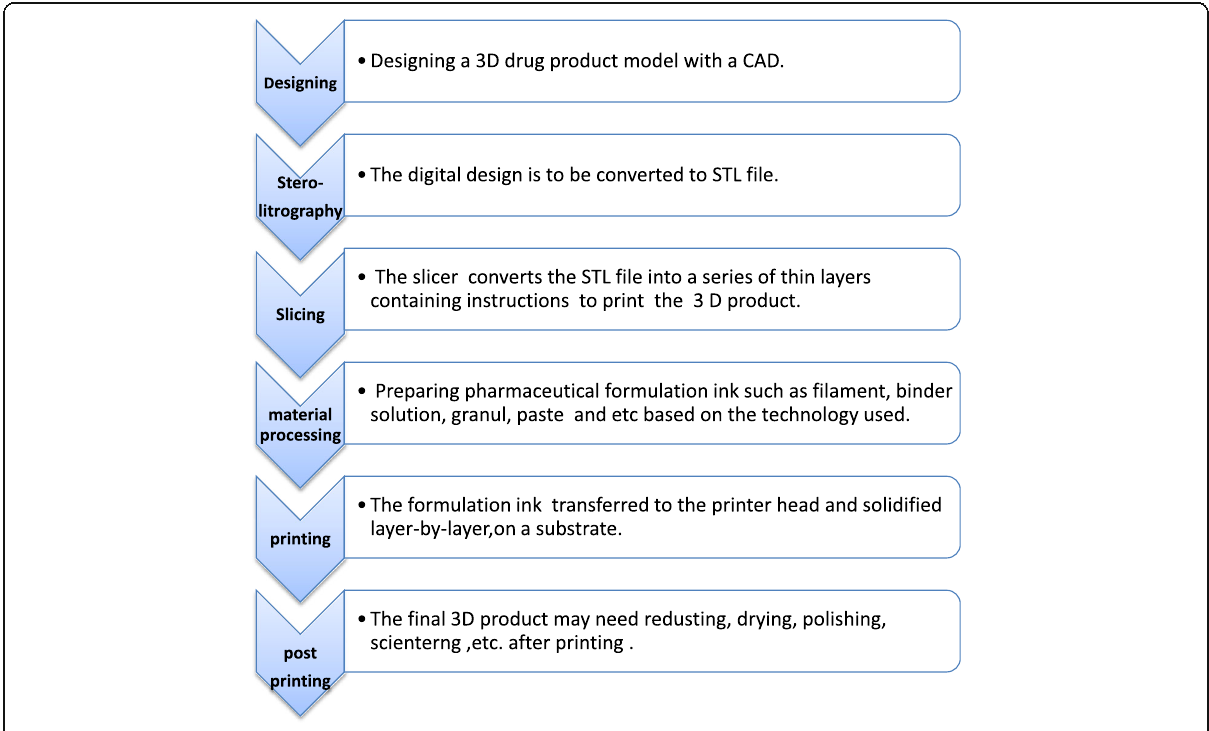
Fig. 2 A schematic representation of different processing steps involved in fabrication of 3D printing